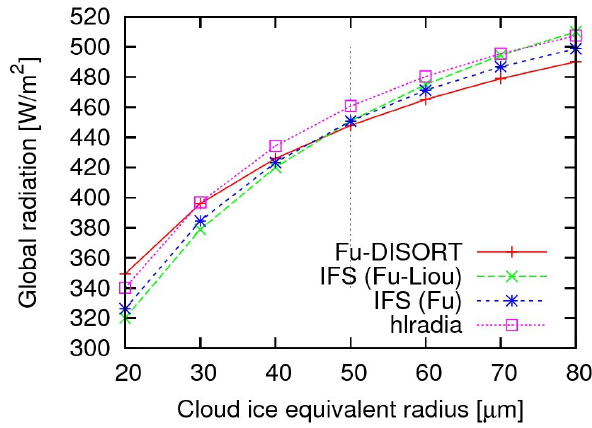
Figure 25. As for Fig. 24 but for surface albedo=0.7 (experi- ment 11).